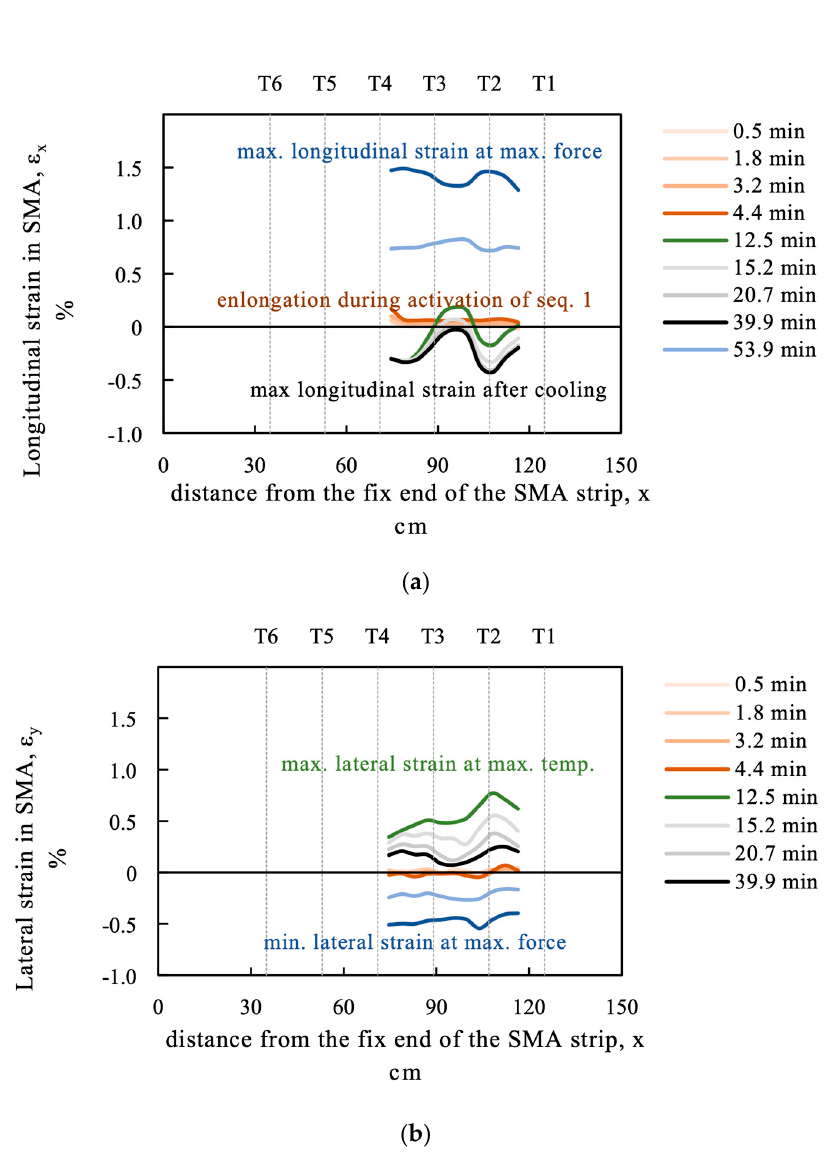
Figure 9. ( a ) Longitudinal and ( b ) lateral strain measurement at the SMA strip obtained from digital image correlation (DIC) at beam SMA_1.